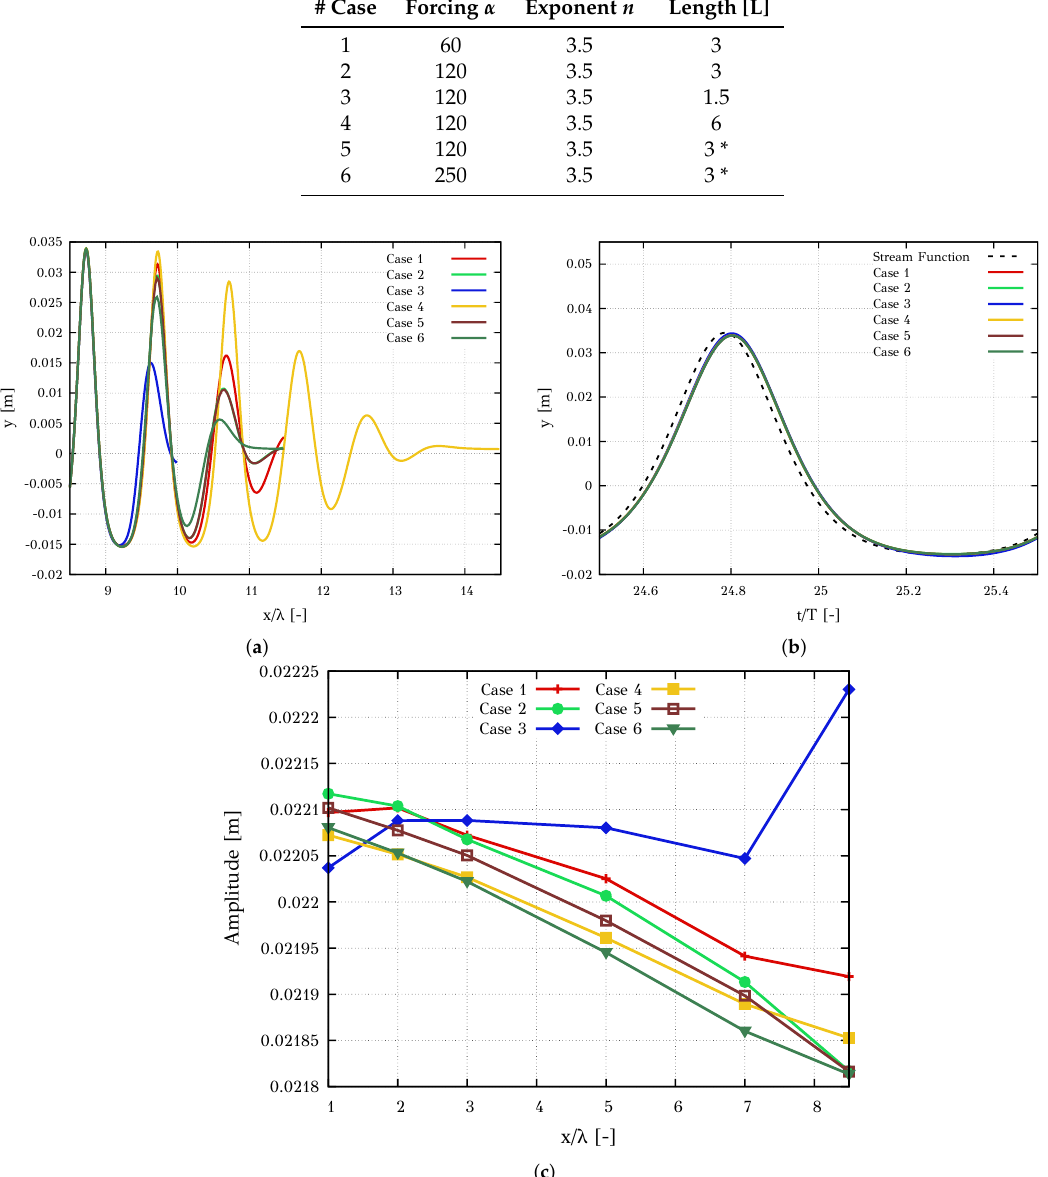
Figure 4. Influence of parameters α and n in the generation of a wave. Wave characteristics: T = 5 s, H = 0.05 m, d = 0.5 m, λ = 11.08 m. ( a ) Wave elevation inside the damping zone after 25 wave periods; ( b ) Wave elevation at a station before the damping zone; ( c ) Amplitude of the 1st harmonic of the wave at various grid